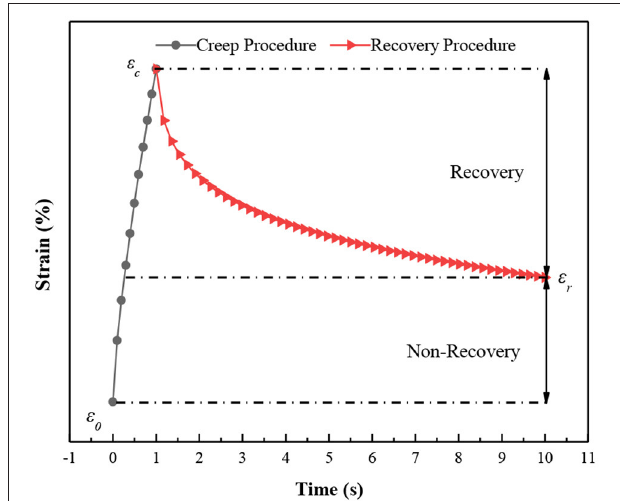
FIGURE 8 | Scheme of MSCR test.